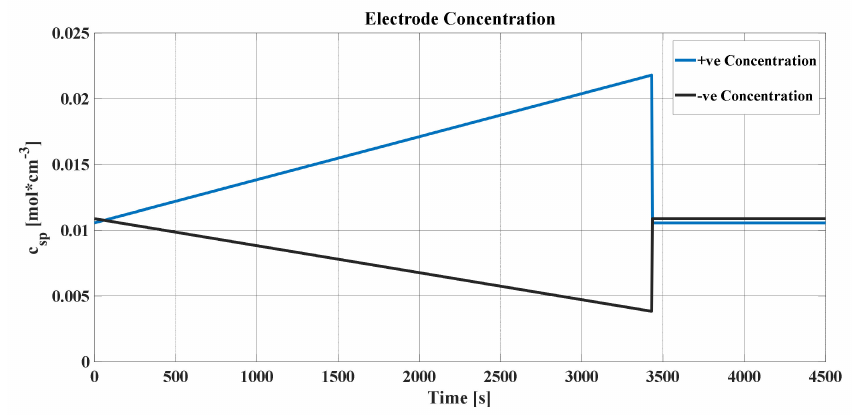
Figure 11. Concentration in both electrodes of the cell